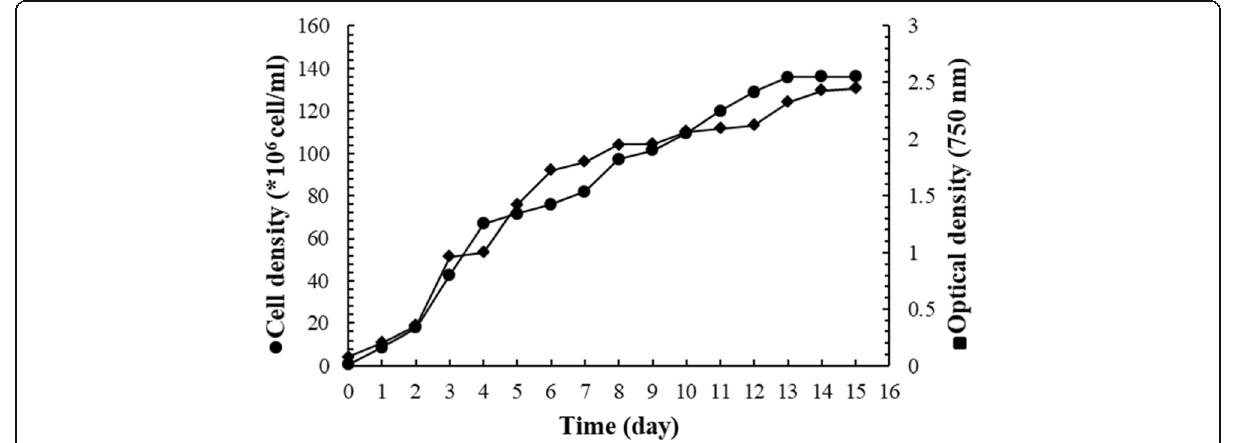
Fig. 4 Chlorella sp. MF1 growth curve in BG11 medium